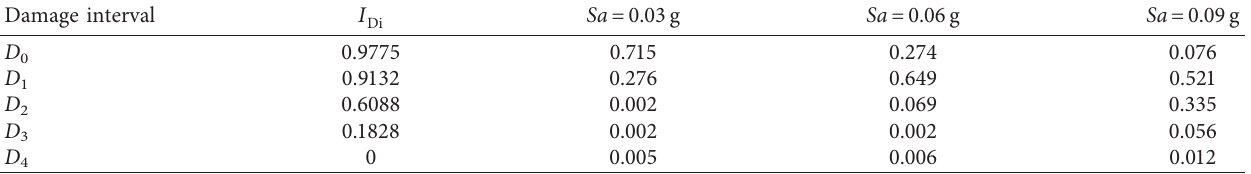
Table 7: Seismic resilience of the stage index and damage probability (section R-F).